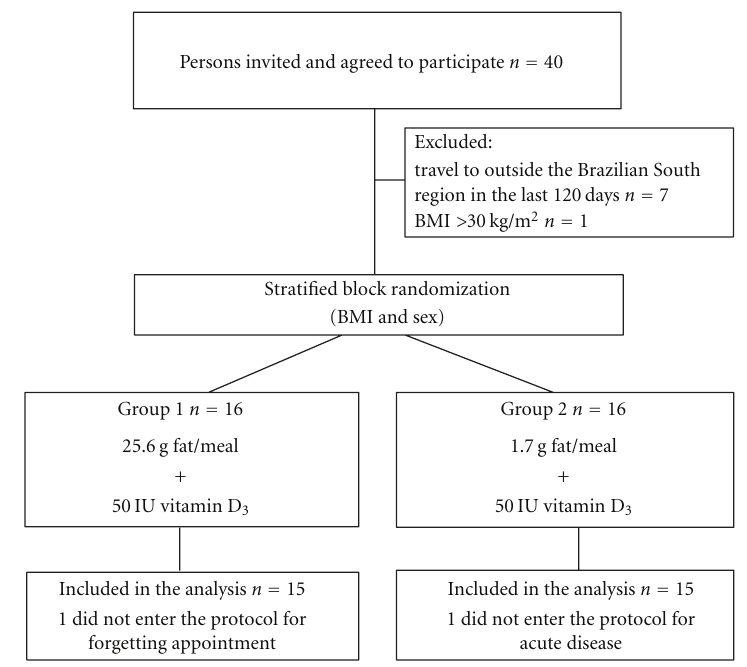
Figure 1: Flow diagram of the participants. Abbreviation: BMI-Weight (kg)/Height (m) 2 . Table 1: Nutritional composition of meals.